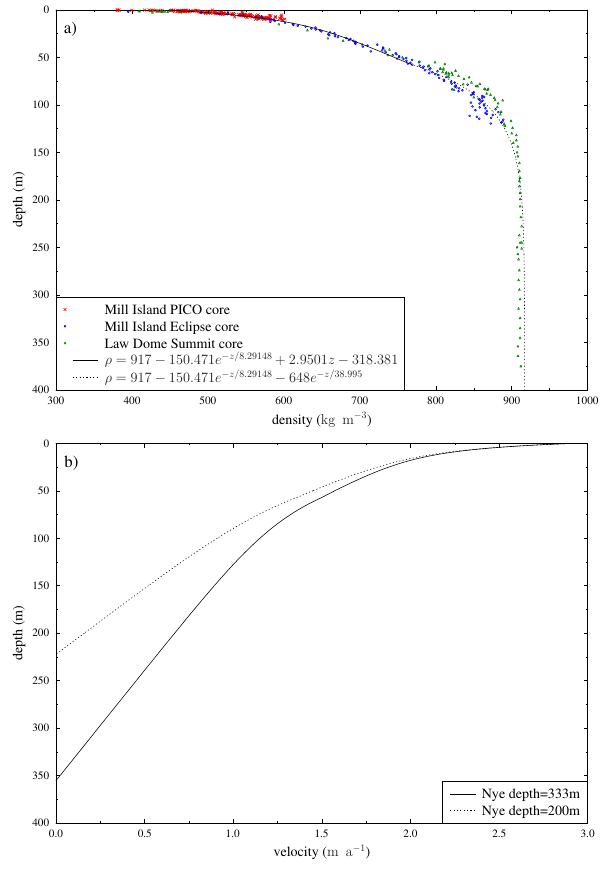
Fig. 4. (a) Density and (b) velocity profiles used in the ground sur- face temperature